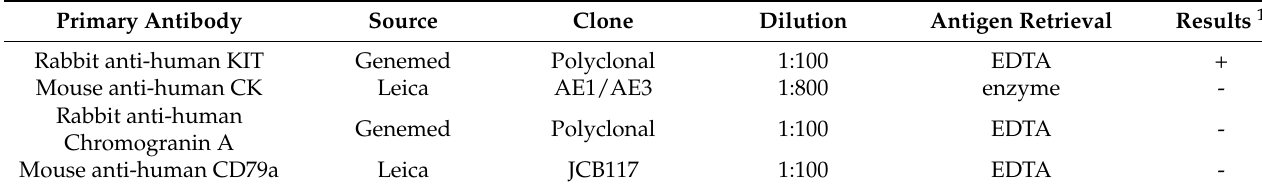
Table 1. Antibodies used for the immunohistochemical evaluation in this case.